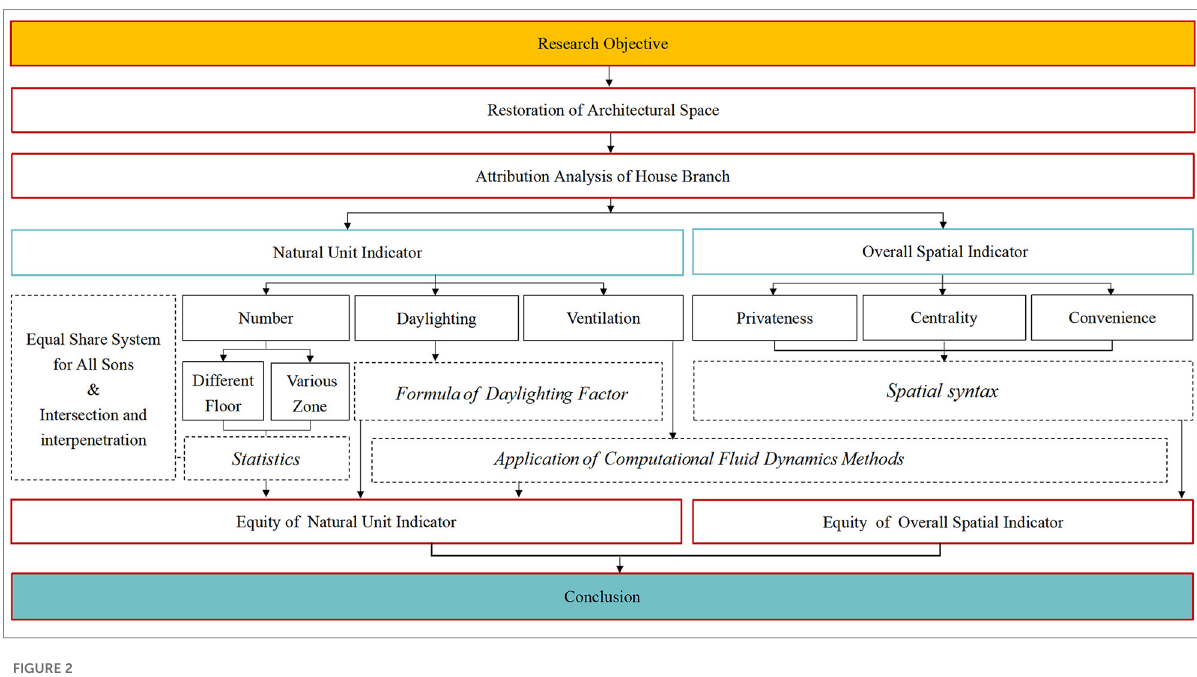
FIGURE2 Framework of this